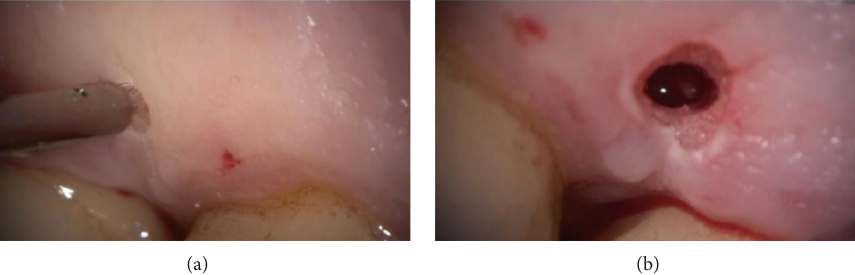
Figure 1: In the case of one or two wall defects, it was possible to use the transgingival approach through the very small access cavity on the basis of the papilla. (a) The sonotrode tip contacting the mucosa surface; (b) the small access after the CUSA